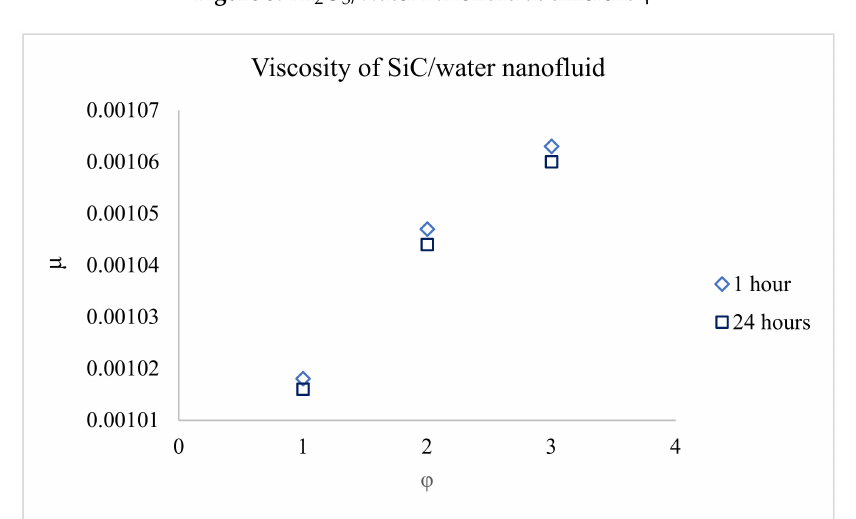
Figure 5. Al 2 O 3 / Water nanofluid at di ff erent ϕ .